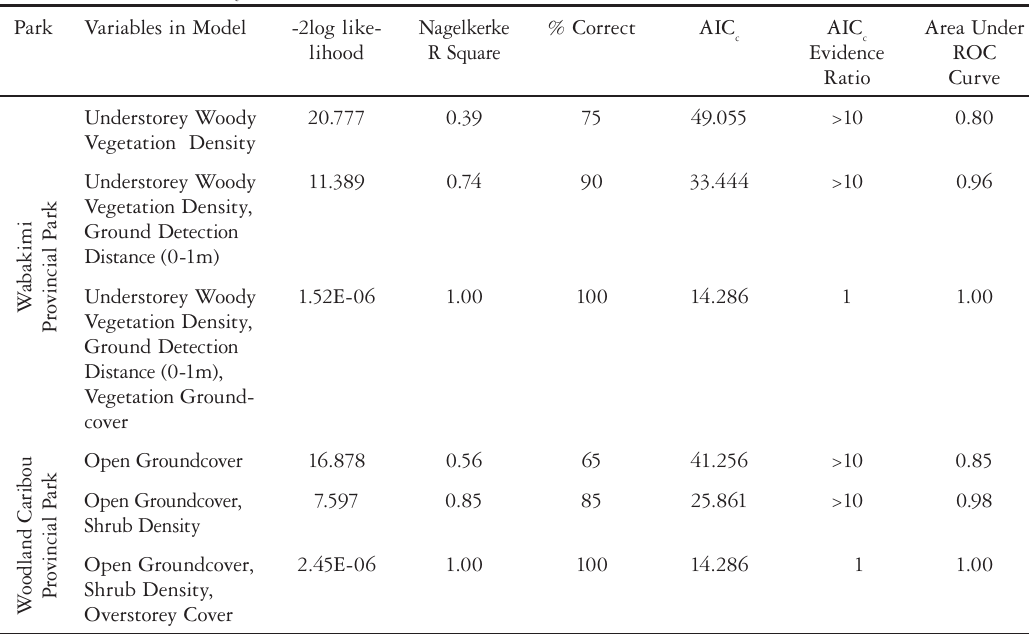
Table 2. Candidate Resource Selection Function models resulting from stepwise logistic regression of 9 variables associ- ated with two-thirds ( n =20) of the caribou nursery and randomly chosen absence sites sampled in Wabakimi Provincial Park and two-thirds ( n =20) of the caribou nursery and randomly chosen absence sites sampled in Woodland Caribou Provincial Park, along with their evaluations by Akaike Information Criterion for small sample size (AIC ) and Receiver Operating Characteristic curves (ROCs). c